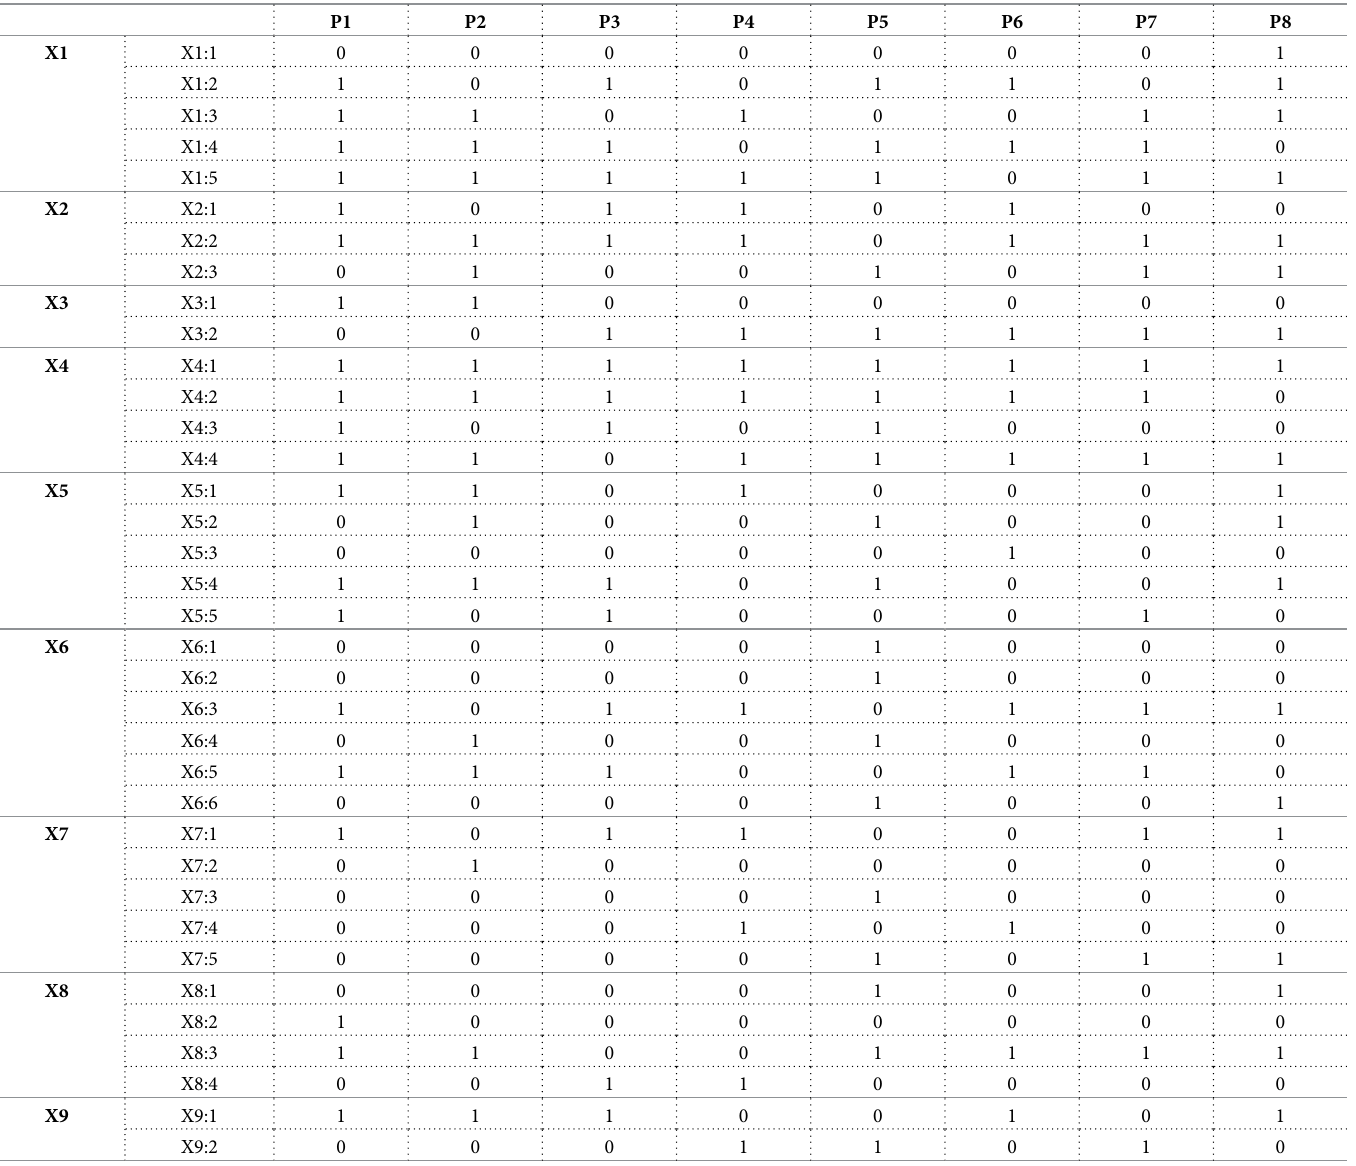
Table 7. Multiple input-output table of eight